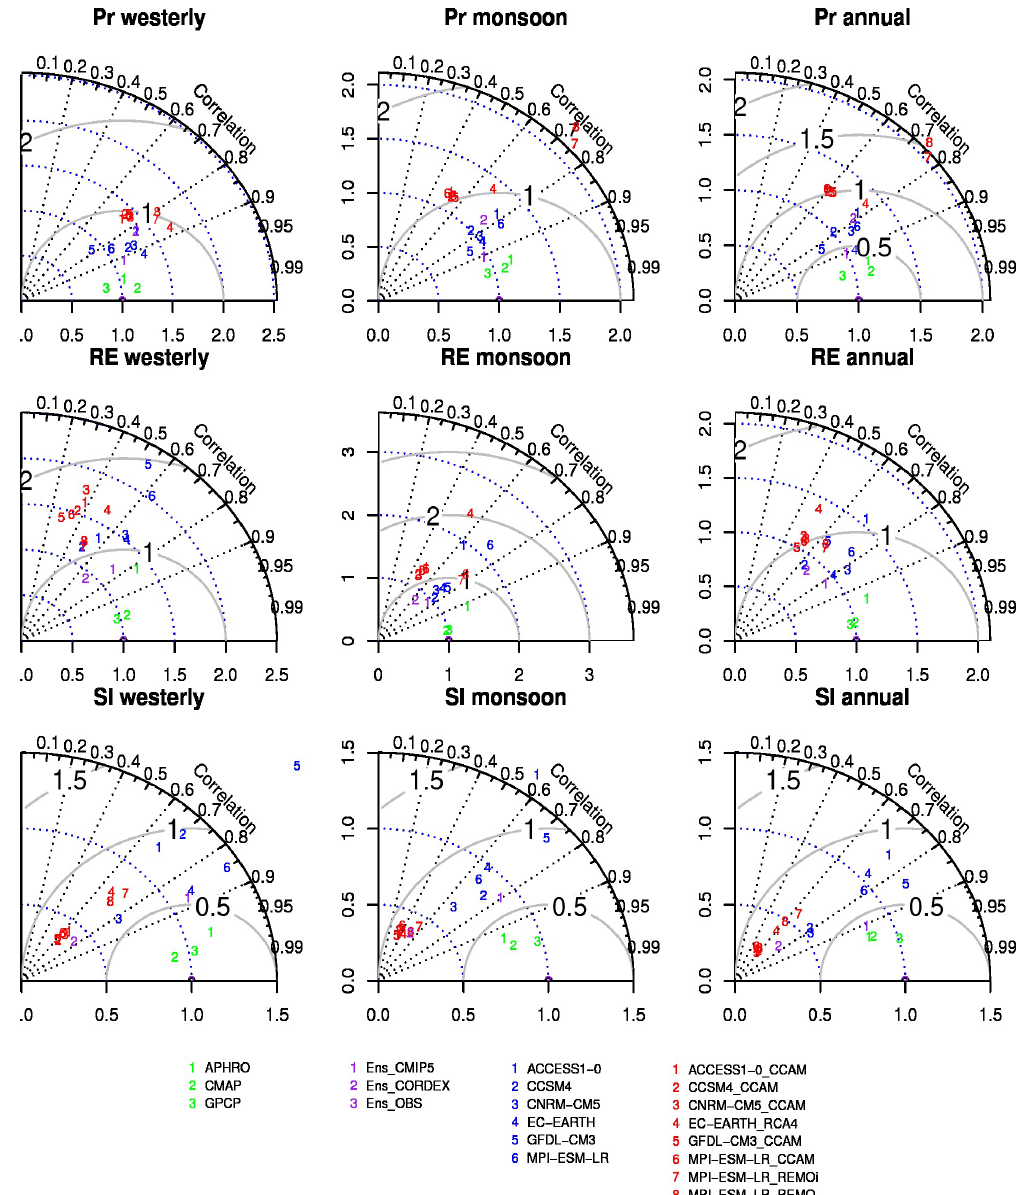
Figure 11. Columns left to right: Taylor Diagrams for the westerly precipitation regime (WPR), the monsoonal precipitation regime (MPR) and annual precipitation, respectively. Rows top to bottom: Taylor Diagrams for precipitation (P), relative entropy (RE) and seasonality index (SI), respectively. Note: The OBS ensemble mean has been taken as a